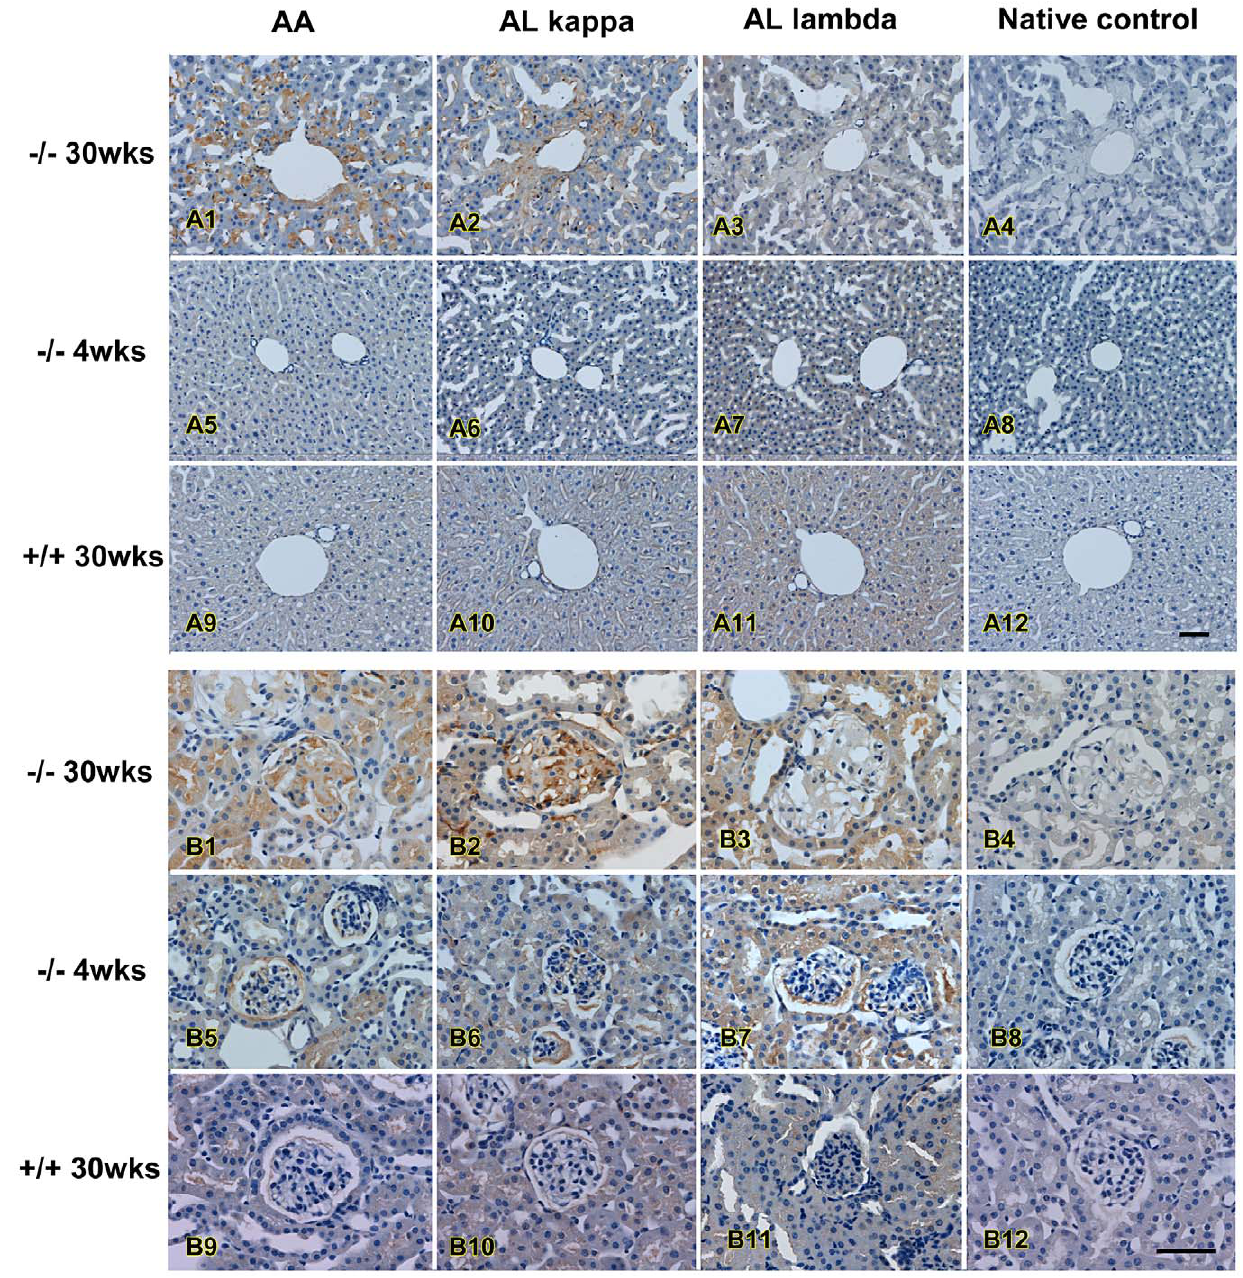
Figure 7. Immunohistochemistry of amyloidosis in affected mice. Immunohistochemistry analysis of amyloids in liver (upper panel) and in kidney (lower panel) of an affected mouse. Antibodies against AA amyloid (AA), k light chain (AL k ), and l light chain (AL l ) were used to differentiate types of amyloid; note progressively increase of amyloid deposition with age. Bar=50 m m.